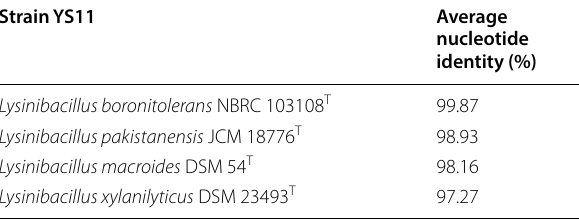
Table 2 Average nucleotide identity (ANI) of strain YS11 with other Lysinibacillus species Strain